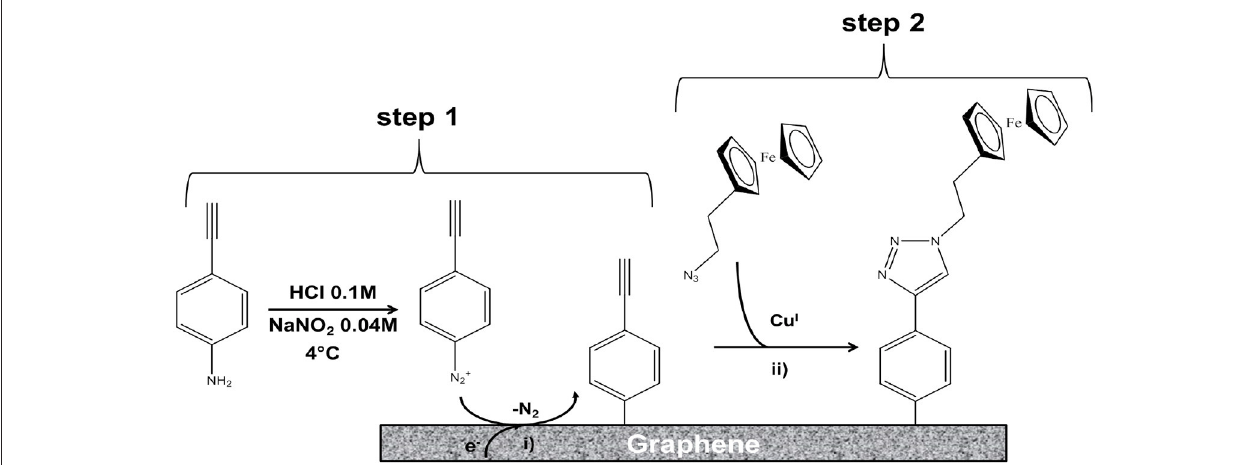
FIGURE 16 | Illustration of the two-step functionalization of a 3D graphene electrode: (Step 1) Electrochemical reduction through cyclic voltammetry of in situ generated diazonium salts for covalent immobilization of 4-ethynylphenyl moieties; (Step 2) CuI-catalyzed Huisgen 1,3-dipolar cycloaddition between the immobilized alkyne functions and the ferrocene derivatives bearing the corresponding azide group; CuI was obtained by reducing CuII with ascorbic acid [Reproduced from Fortgang et al. (2016) with permission of ACS